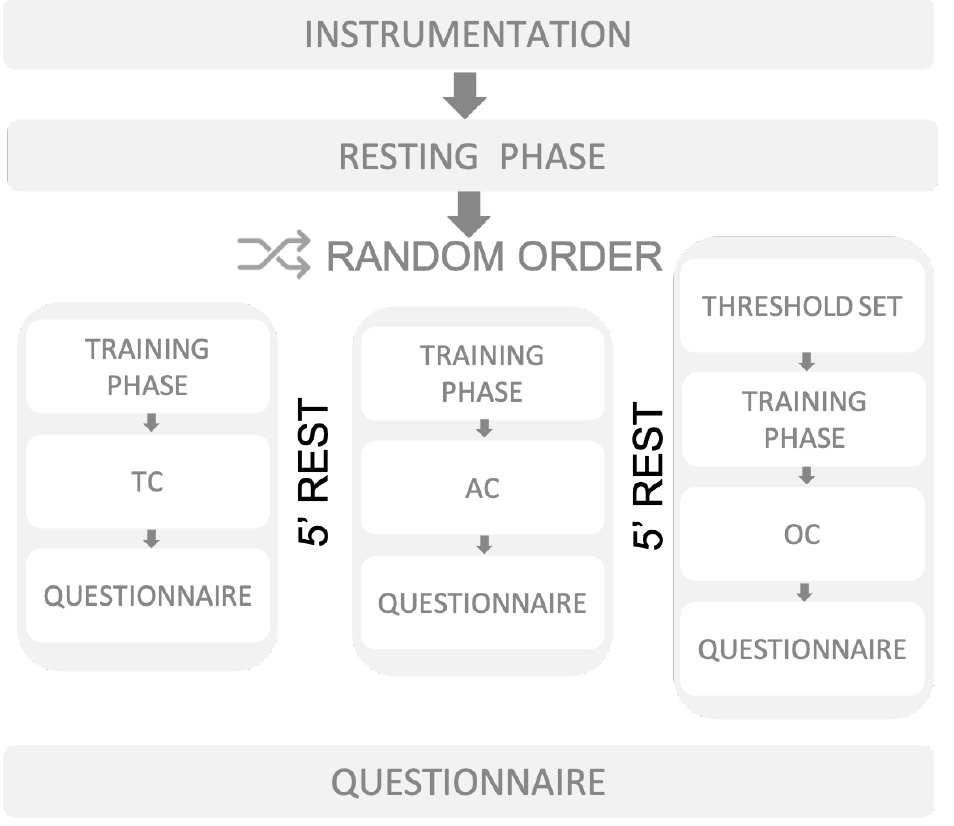
Figure 6. Schematics of the experimental protocol followed for each